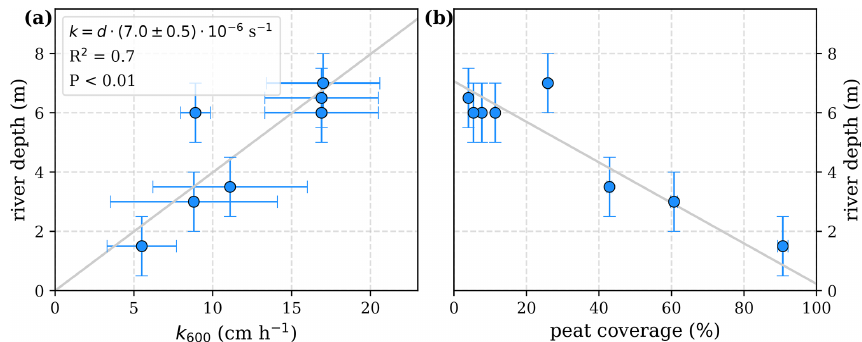
Figure A1. Correlation of river depth with (a) atmospheric exchange coefficients ( k 600 ) and (b) catchment peat coverage. A linear correlation between river depth and exchange coefficient reveals a slope of k 600 /d = ( 2 . 5 ± 0 . 2 ) cmh − 1 m − 1 = ( 7 . 0 ± 0 . 5 ) × 10 − 6 s − 1 .